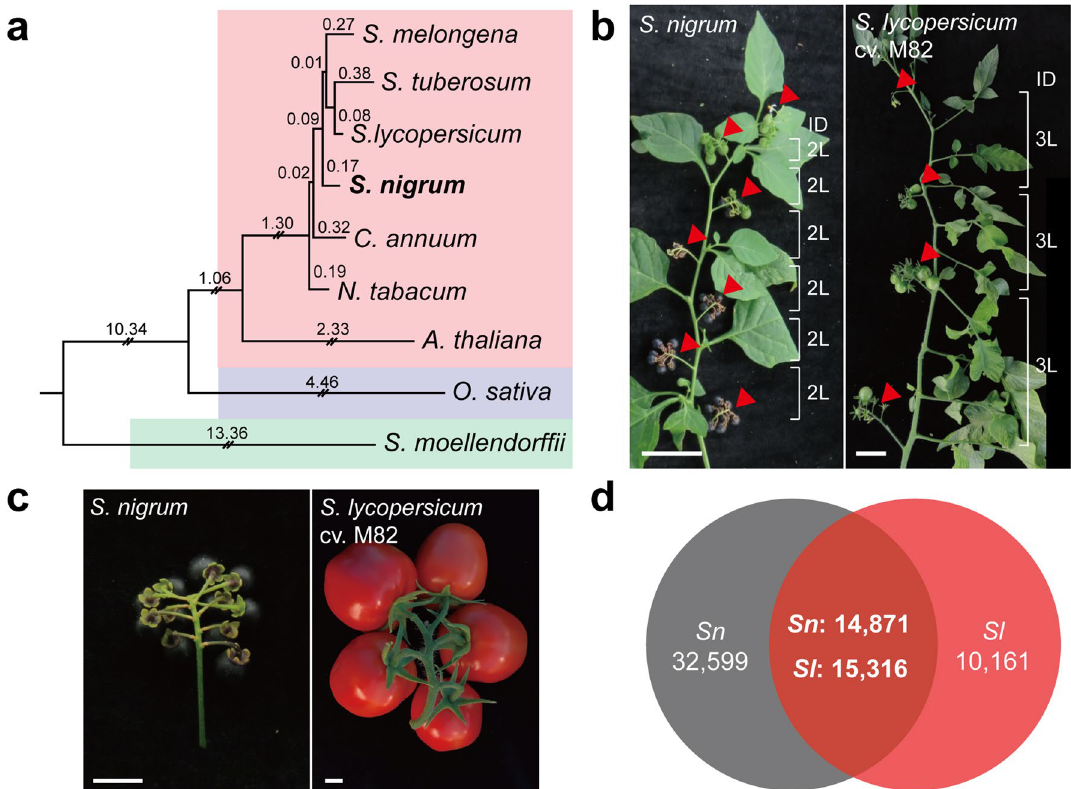
Figure 3. Evolutionary conservation and variation in S. nigrum and S. lycopersicum . ( a ) Phylogenetic tree constructed using chloroplast proteins of S. nigrum with Solanaceae, Arabidopsis , rice, and primitive species. Distances in the tree represent percent accepted mutation (PAM) units. Red box, dicot; blue box, monocot; green box, primitive species. ( b ) Comparison of sympodial shoot structure. Red arrowheads indicate inflorescences. Brackets and numbers represent the number of leaves (L) between inflorescences. ID, indeterminate growth. Scale bars, 5 cm. ( c ) Comparison of ripe fruits with inflorescence between S. nigrum and S. lycopersicum . Scale bars, 1 cm. ( d ) Venn diagram showing orthologs between S. nigrum unigenes and S. lycopersicum- expressed genes based on hierarchical orthologous groups analysis. Sn , S. nigrum ; Sl , S. lycopersicum